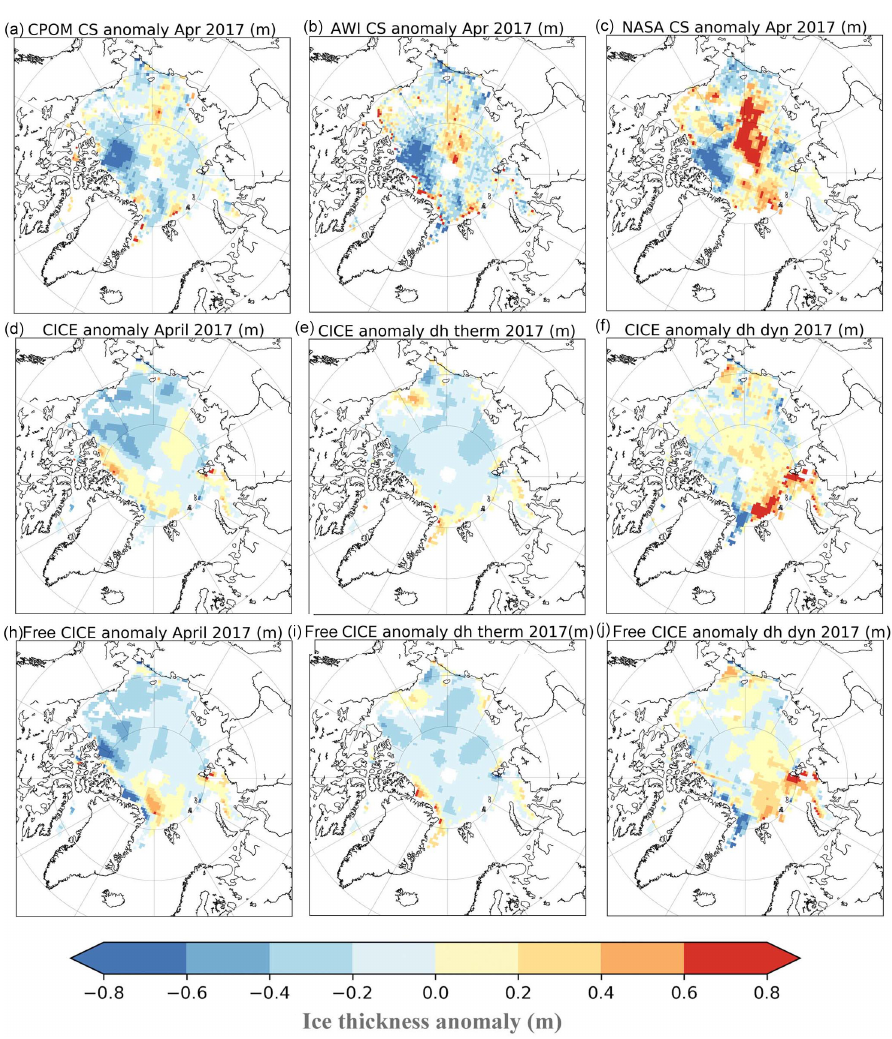
Figure 4. CryoSat-2 and CICE simulated thickness anomalies in April 2017 relative to the 2011–2017 mean. The top row of panels show the total ice thickness anomalies from CryoSat-2 for CPOM (a) , AWI (b) and NASA (c) . Panel (d) shows April 2017 thickness anomalies from CICE initialized with CPOM November CS2 thickness together with the contributions from thermodynamics (e) and dynamics (f) and panels (h–j) shows the corresponding results from the CICE free simulations. Grid points with less than 100 individual measurements and a mean sea ice thickness of less than 0.5m are not